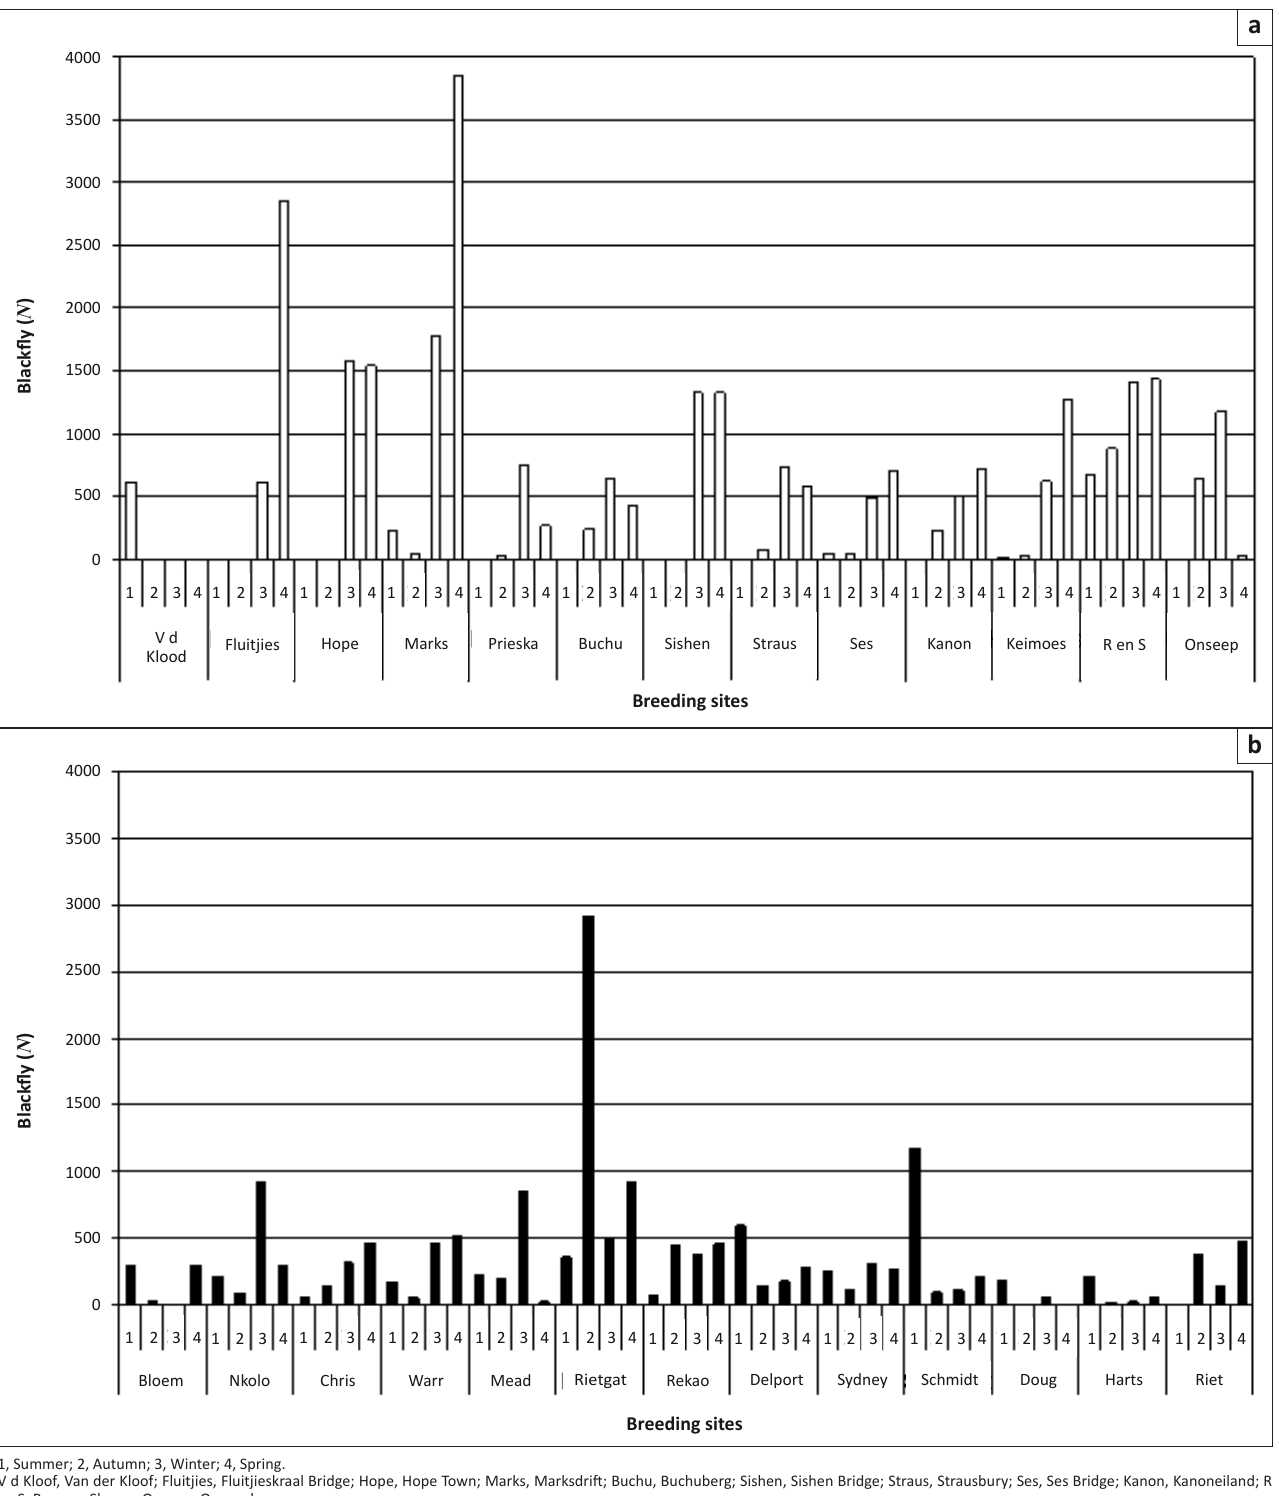
FIGURE 4: Blackfly larval and pupal numbers sampled from sites along, (a) the Orange River and (b) the Vaal River and its